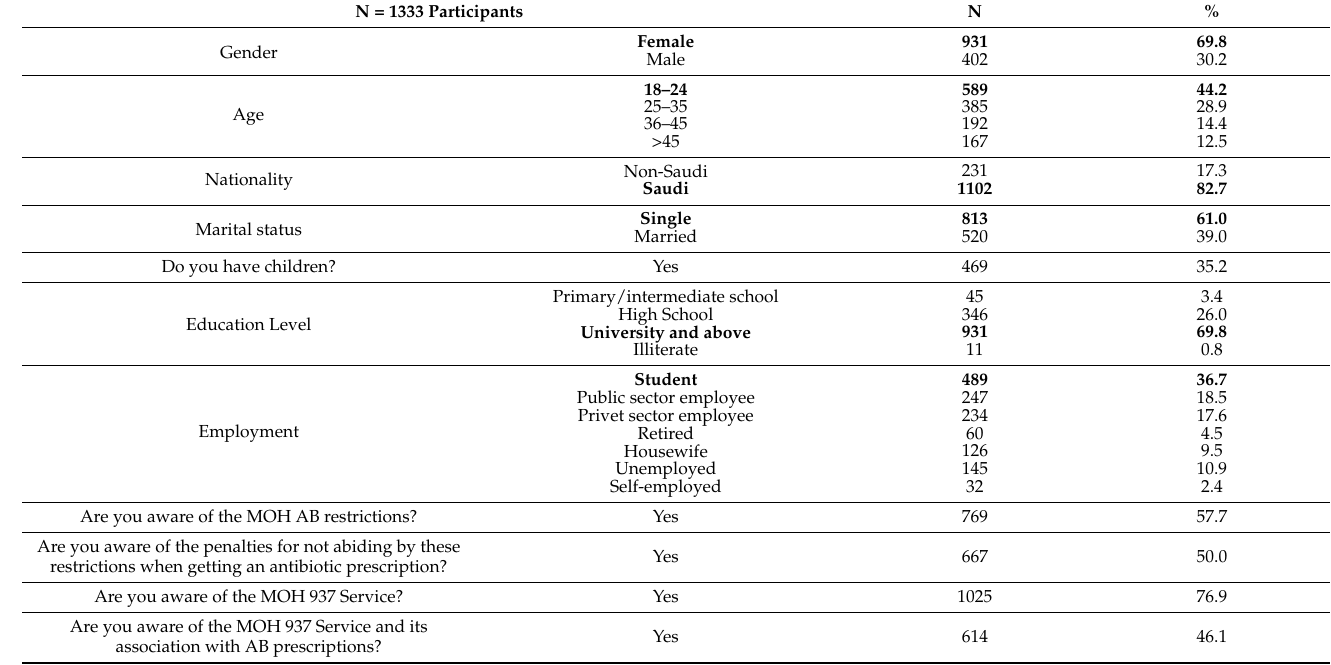
Table 1. Demographic parameters of survey participants and a knowledge assessment related to the new Ministry of Health (MOH) antibiotic (AB)